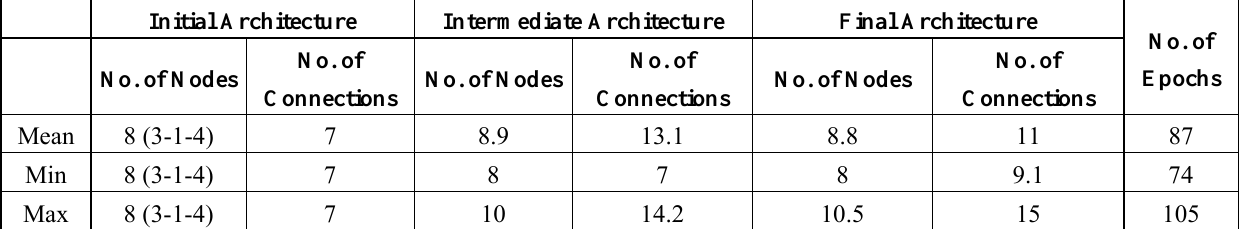
Table 6. ANN architectures and the training epochs for the season dataset.